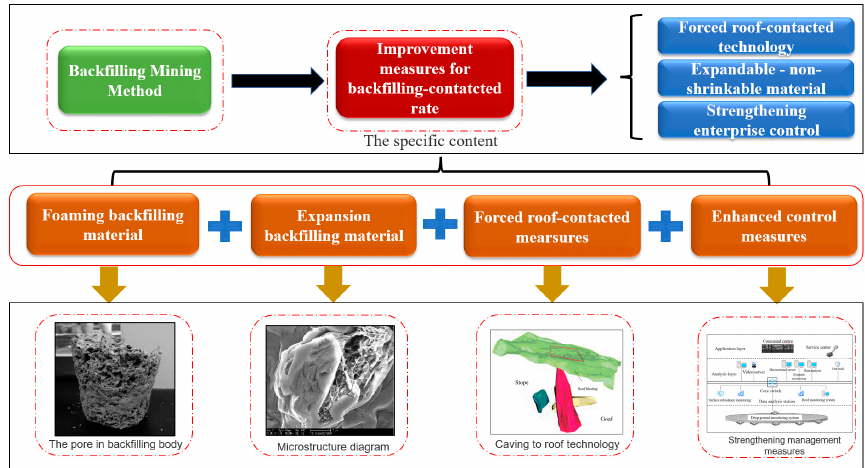
Figure 13. Influence structure of roof-contacted improvement